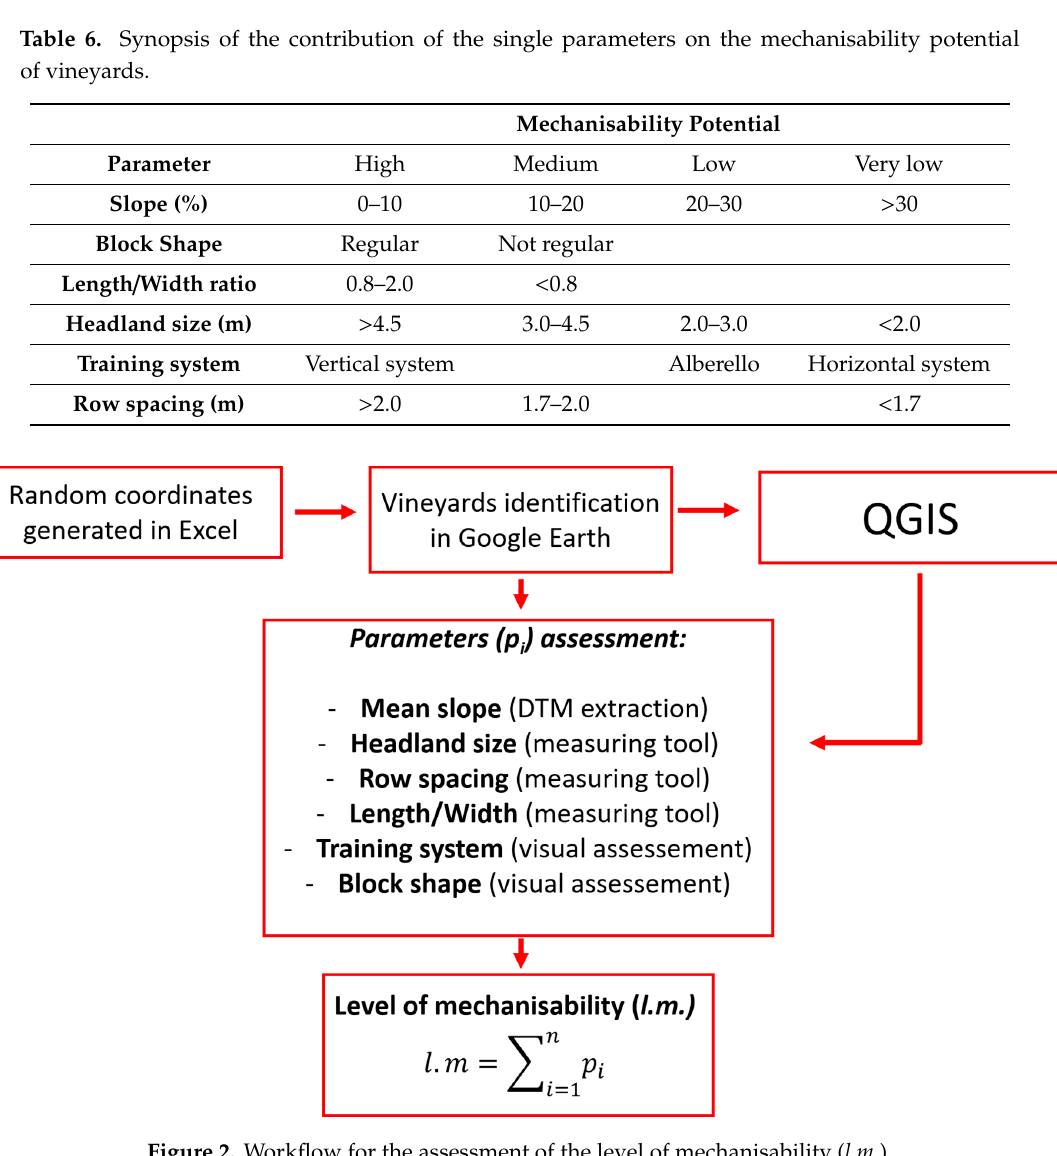
Figure 2. Workflow for the assessment of the level of mechanisability ( l.m. ).